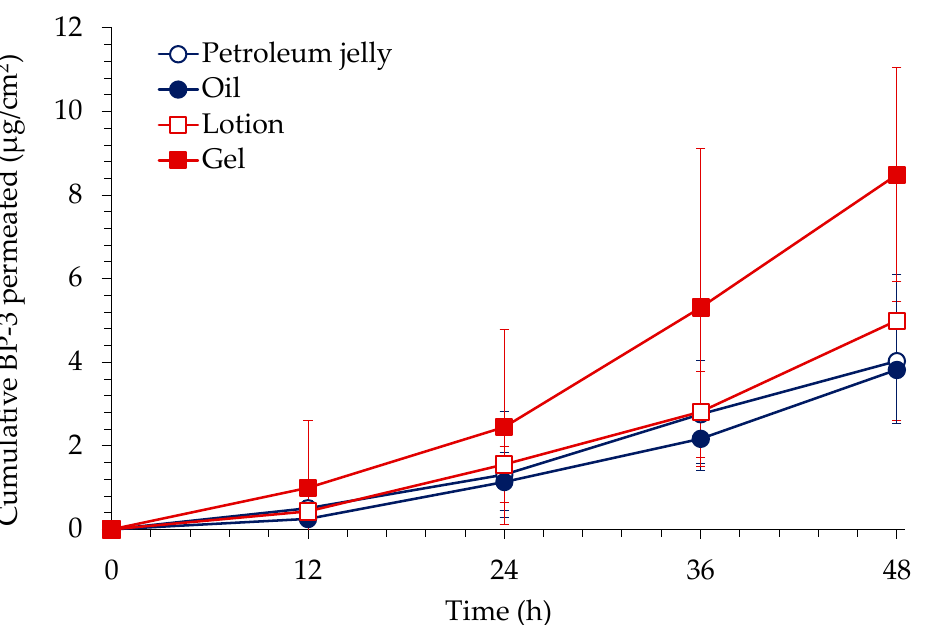
Figure 1. In vitro skin permeation profile of BP-3 through excised rat skin after application of BP-3 formulations (mean ± S.D., n = 6 each). Table 2. In vitro skin deposition of BP-3 in the stratum corneum and the epidermis/dermis of excised rat skin after 48 h application of BP-3 formulations (mean ± S.D., n = 6).